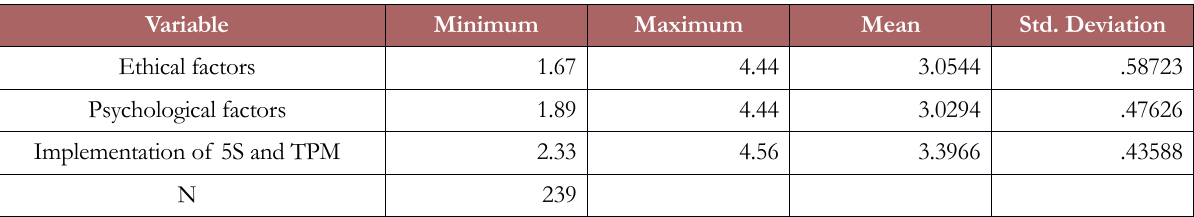
Table 4. Descriptive statistics for variables of